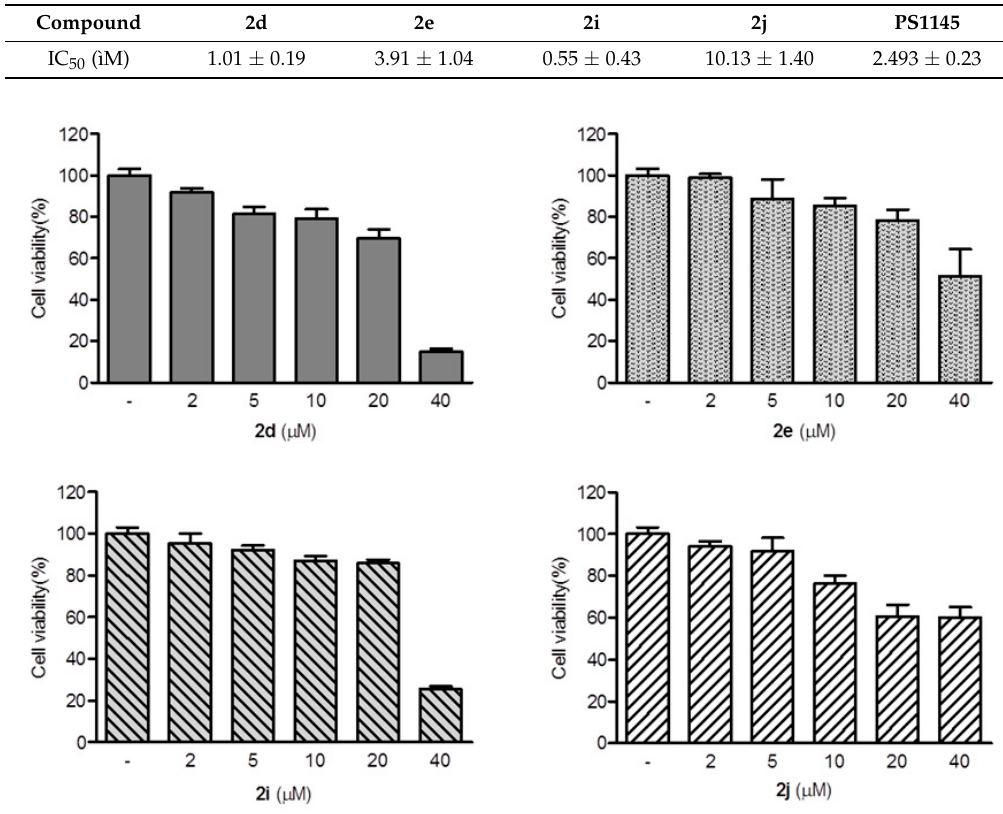
Figure 2. Cytotoxic effects of compounds 2d , 2e , 2i and 2j on 293T cells. Following pretreatment with compounds 2d , 2e , 2i and 2j at the indicated concentrations for 24 h, the cell viability of 293T cells were determined by MTT assay.